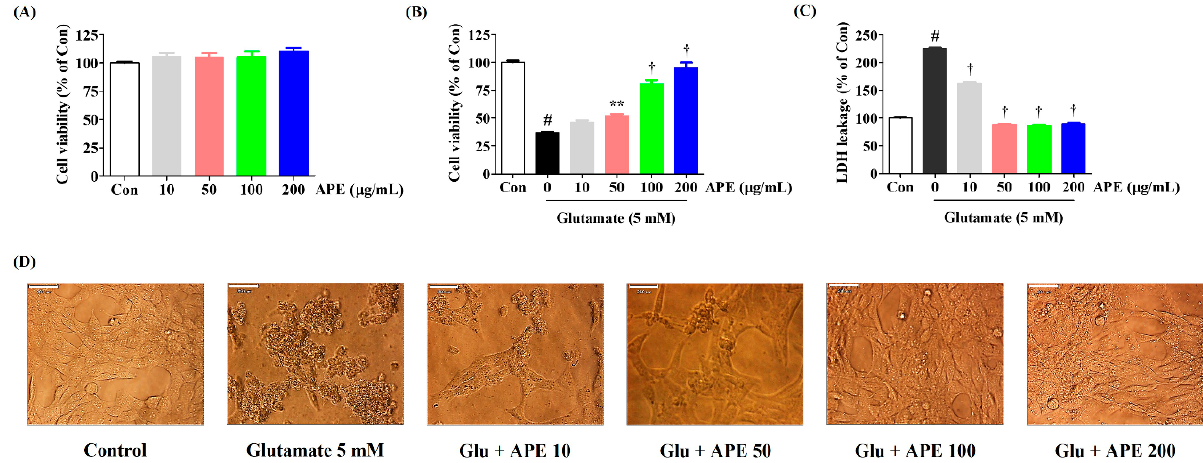
Figure 1. Effects of Arecae Pericarpium ethanol extract on glutamate-induced cytotoxicity in HT22 cells. ( A ) HT22 cells were incubated with APE at concentrations of 10, 50, 100, or 200 μ g/mL. ( B – D ) After APE pretreatment, the HT22 cells were stimulated with glutamate (5 mM). ( D ) The images represent the three independent experiments, shown at 1000× magnification. Scale bar = 20 μ m. Control was non-treated cells. Data were presented as mean ± standard error of the mean. Statistical significance was set at # p <0.05 (vs. control), ** p < 0.01, and † p < 0.001 (vs. glutamate). APE, Arecae Pericarpium ethanol extract; Con, control; Glu, glutamate; LDH, lactate dehydrogenase.